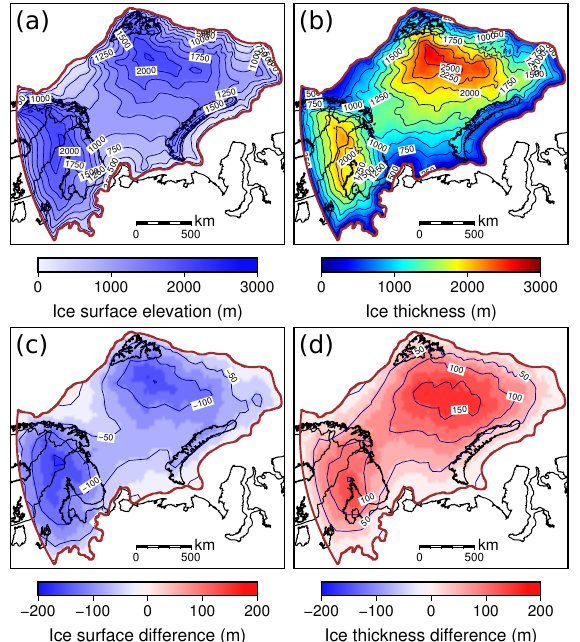
Figure 5. Ice sheet reconstruction after one iteration of GIA. (a) Ice surface elevation. (b) Ice thickness. (c) Difference in elevation be- tween (a) and the initial model without GIA deformed topography. (d) Same as (c) but for ice